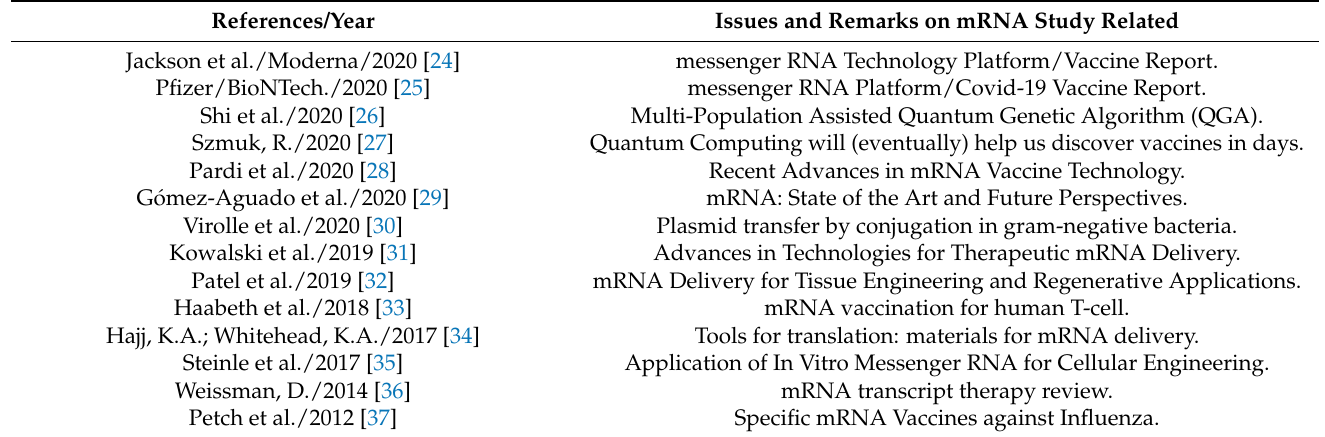
Table 2. Summary of the literature review on Quantum messenger RNA (QmRNA) and